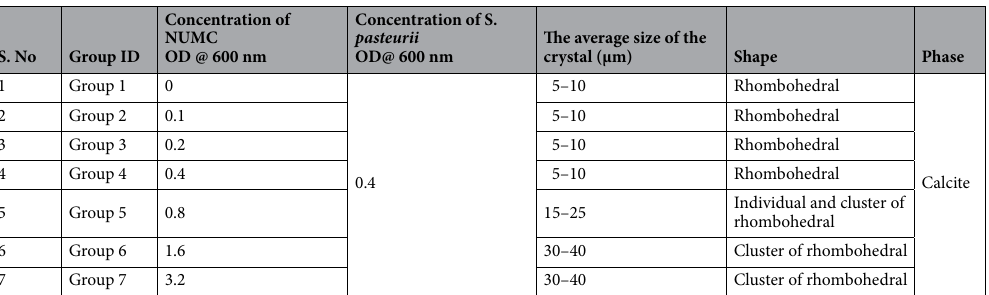
Table 4. The morphology and phase characterization of CaCO 3 crystals—bioaugmentation. NUMC Native Ureolytic Microbial Community.